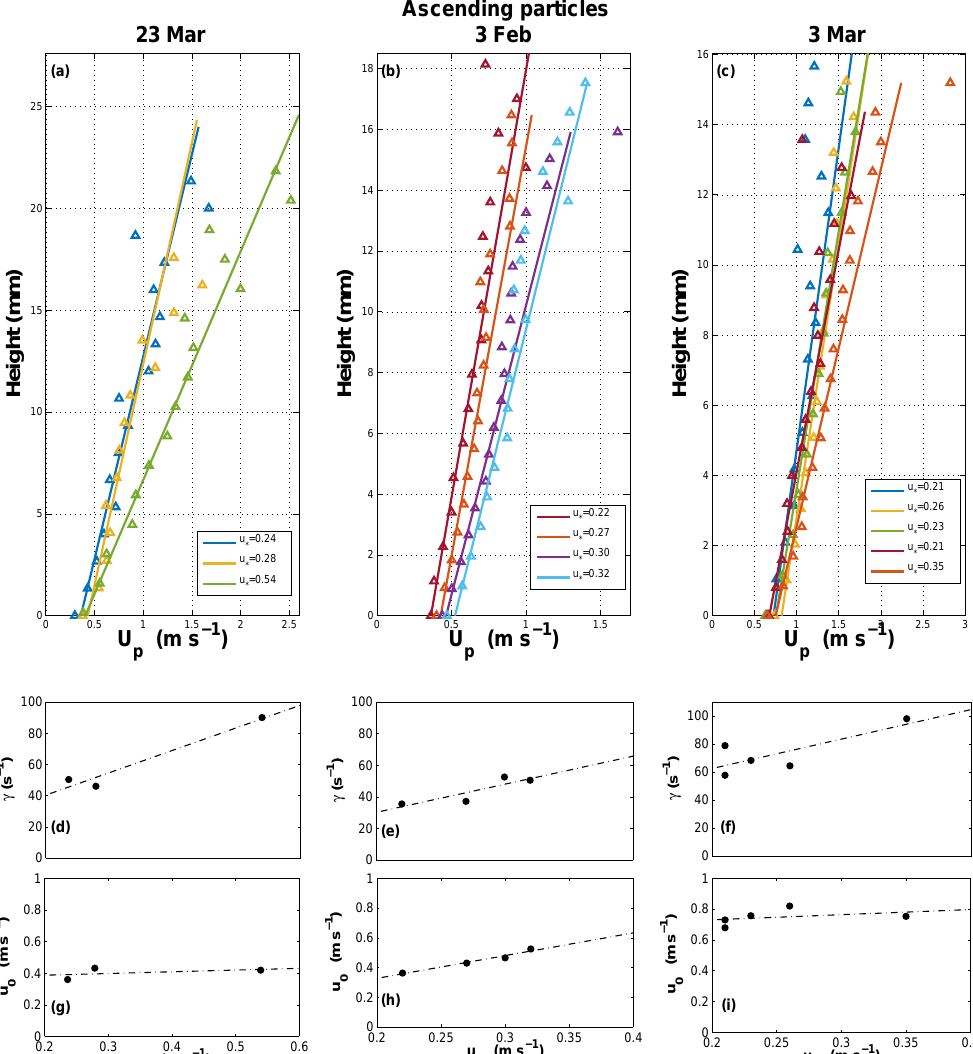
Figure 6. (a–c) Average ascending snow particle horizontal velocities in lower saltation layer (triangles) with best-fit linear profile for the first 10mm. u ∗ values are calculated from 200, 25, and 10cm for 23 March, 3 February, and 3 March respectively. (d–f) Friction velocity vs. particle velocity gradient ( γ ) for each recording. (g–i) Friction velocity vs. particle slip velocity ( u 0 ) for each